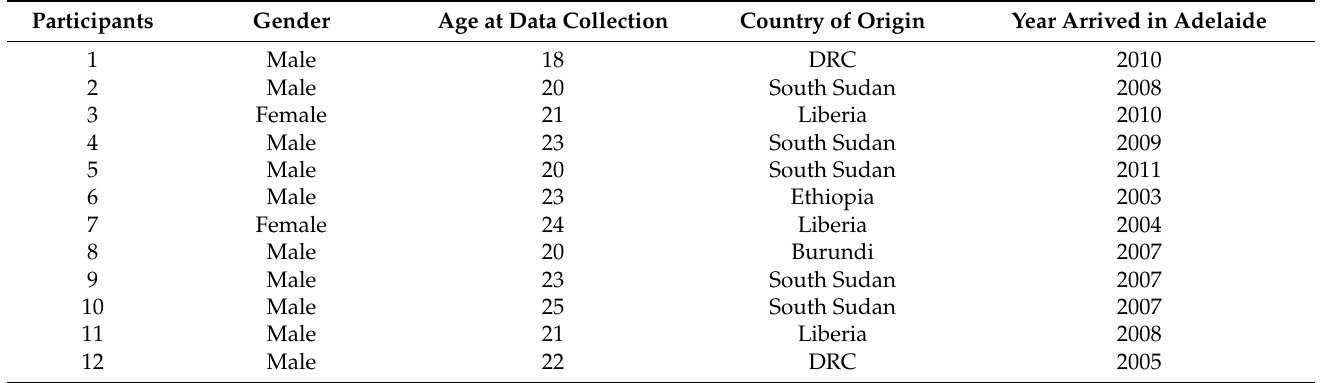
Table 3. Characteristics of face-to-face interview